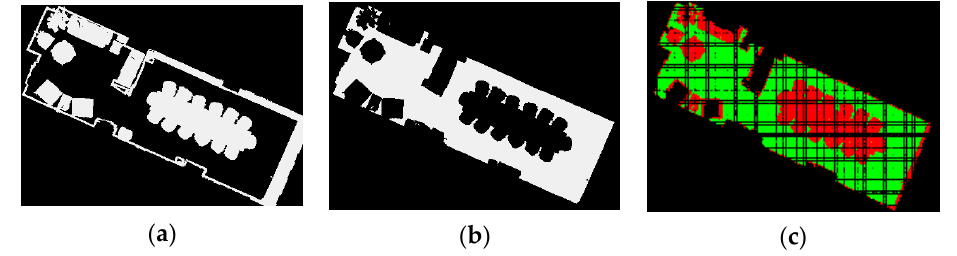
Figure 16. PAM with height range (0–1.2): ( a ) the obstacle map in binary format, ( b ) PAM in image format, and ( c ) PAM in point cloud format.